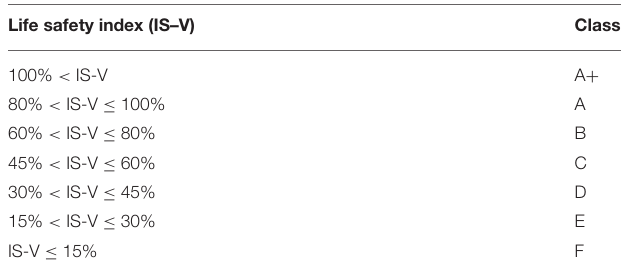
reconstruction cost percentage values (CR % )